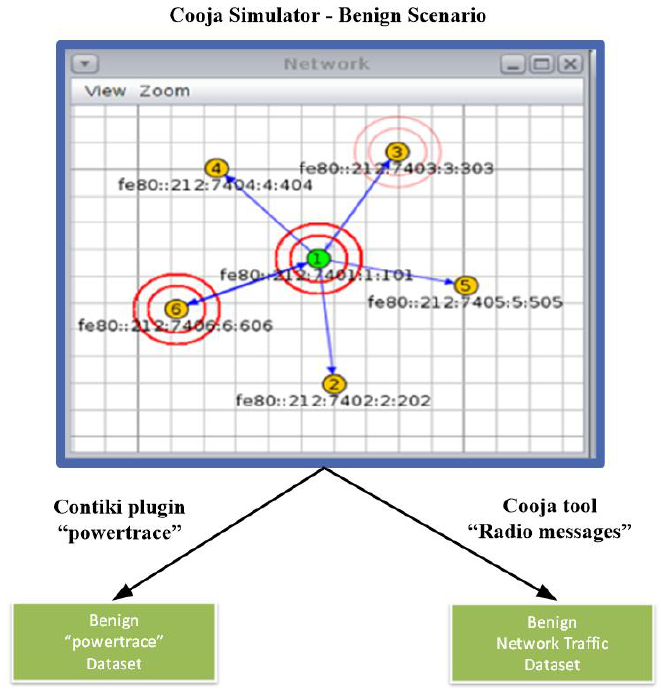
Figure 2. B enign datasets generation by utilizing the Cooja simulator . Figure 2. Benign datasets generation by utilizing the Cooja